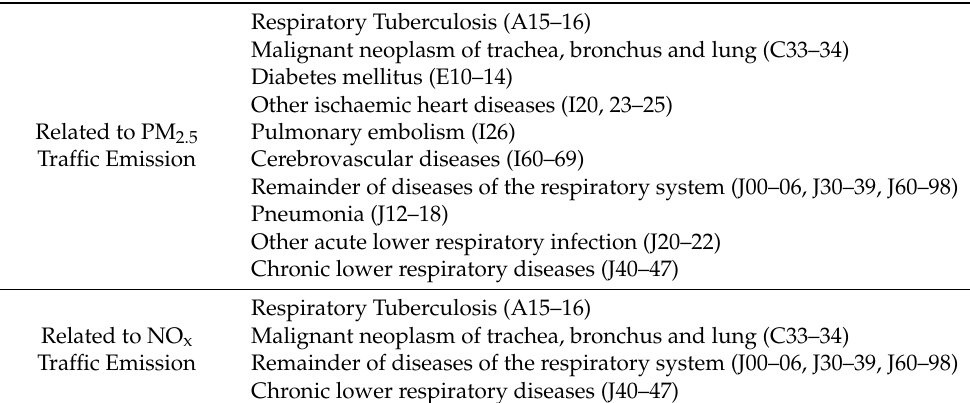
Table 1. Types of diseases (ICD codes) * considered for the calculation of mortality rates of each district (time period: